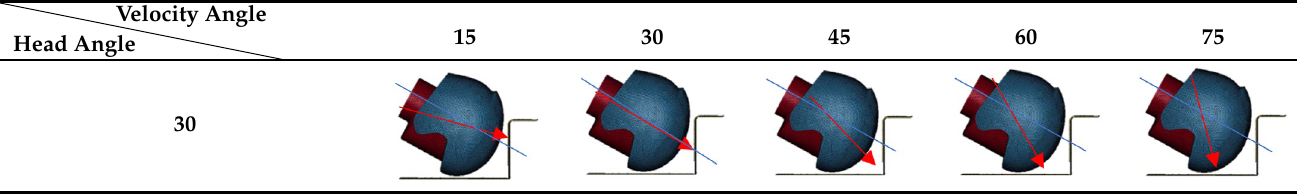
Table 4. Directions of head impact and impact velocity.